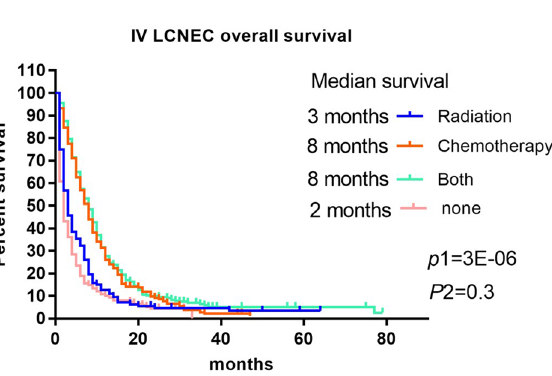
Figure 3. Prognostic risk score in patients in advanced LCNEC.